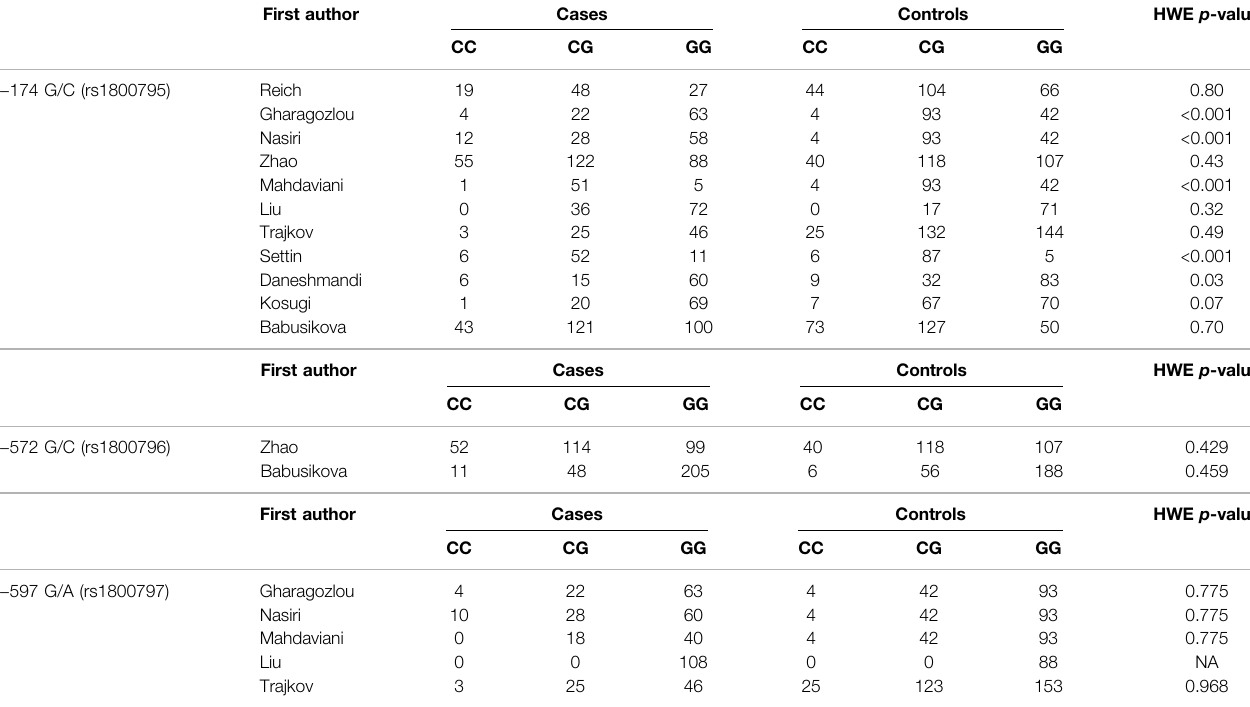
TABLE 2 | Distribution of the IL-6 genotype among cases and controls included in this